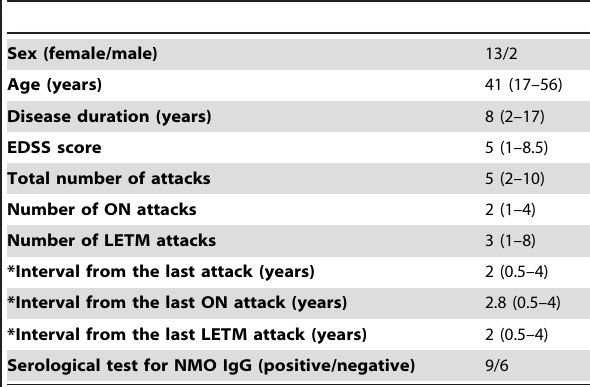
Table 1. Demographic and clinical characteristics of patients with relapsing neuromyelitis optica